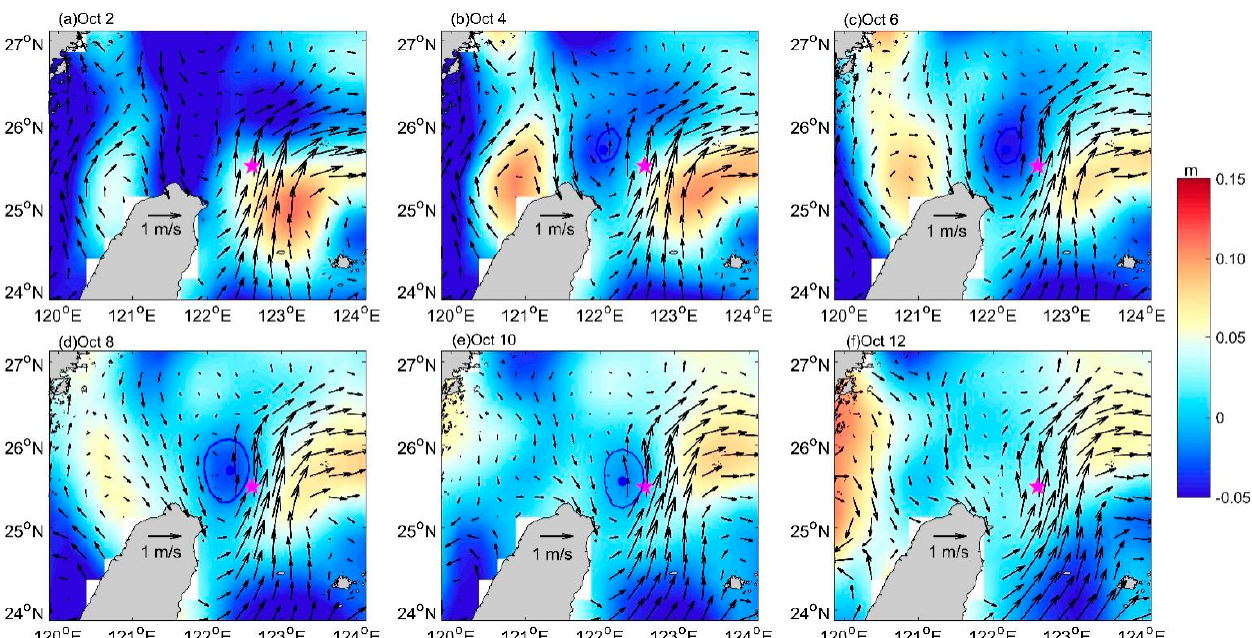
Figure 13. Distribution of sea level anomalies (colors) and geostrophic currents (arrows) in the southwestern East China Sea, and the mooring is denoted by purple star. Figures ( a–f ) correspond to 2 October 2019 to 12 October 2019 with an interval of 2 days. In Figures ( b – e ), the blue solid lines and dots represent the boundaries and centers of the cyclonic eddy, respectively, calculated according to Nencioli et al. [60].